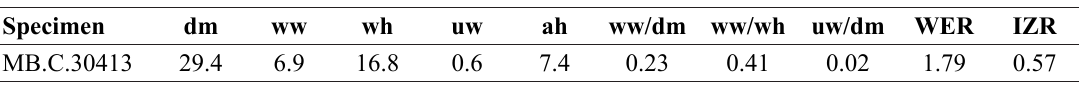
Table 4. Conch dimensions and ratios of Lentitornoceras materni gen. et sp. nov., holotype (MB.C.30413).